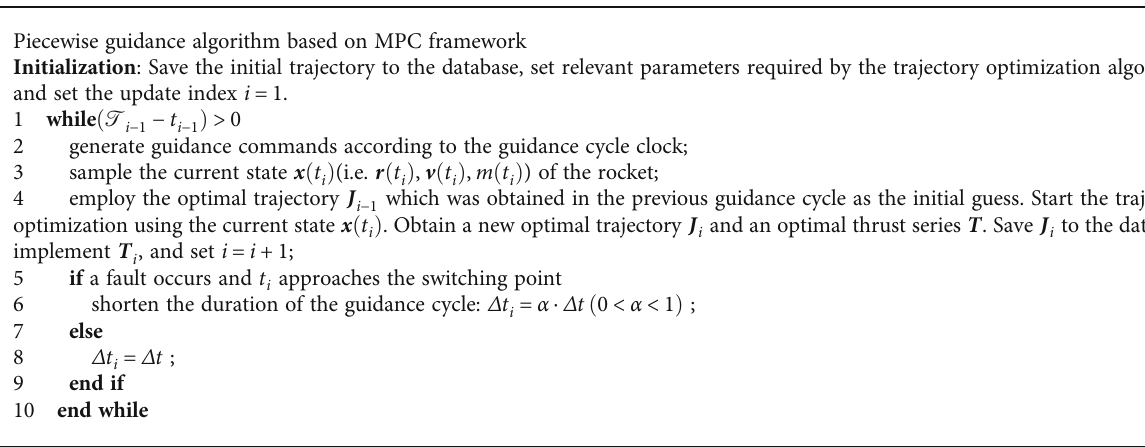
Piecewise guidance algorithm based on MPC framework